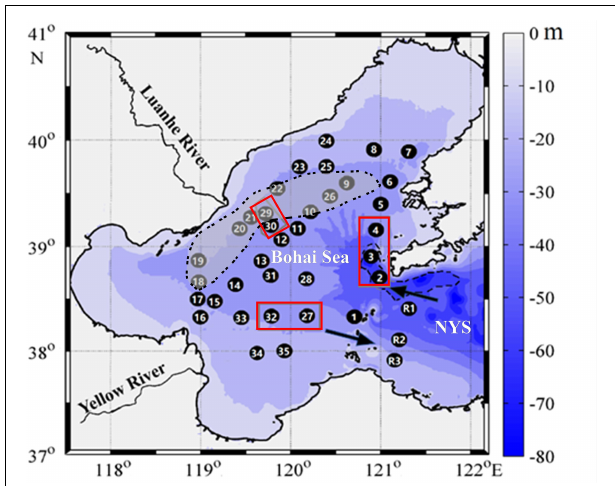
FIGURE 1 | Sampling sites in the Bohai Sea and the North Yellow Sea (NYS). The deep Laotieshan Channel is circled by a dashed line. The Bohai Sea inflow current and Bohai Sea outflow current are indicated by arrows. Stations 2, 3, and 4 are located in the Laotieshan Channel. Stations 27 and 32 are located near active oil/gas platforms (Zhang et al., 2014). Incubation experiments were carried out at stations 29 and 30, in or near a bottom-water oxygen-depletion region (the gray shadowed area circled by a dotted line) observed in late August 2011 by Zhai et al.